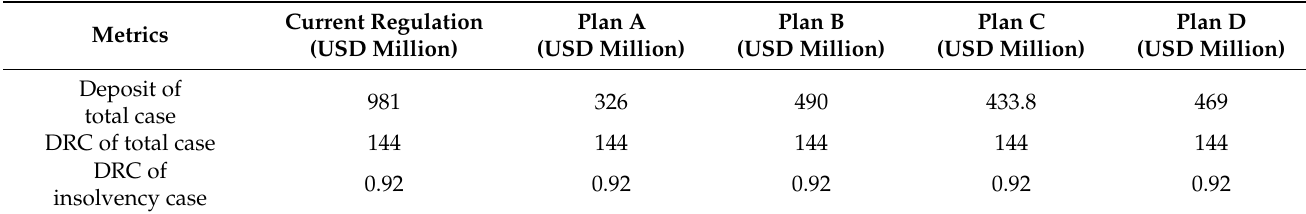
Table 4. Statistics of deposit and DRC.